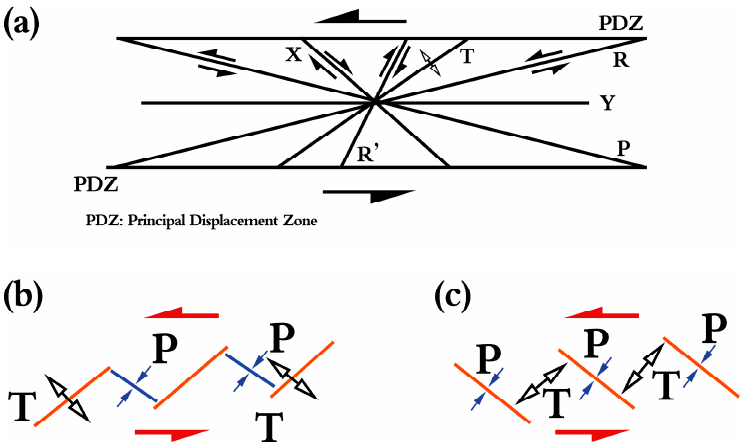
Figure 9. The Riedel shear in strike-slip fault zone. ( a ) An idealized Riedel shear zone is composed of six principal elements, which are X shear and Y shear faults, Riedel (R) and R ′ conjugate shears, T tensional fractures, and P shears, which are all oriented at specific angles with respect to the general trend of the shear zone. ( b ) Mechanism of the right-stepping in strike-slip fault zone. ( c ) Mechanism of the right-stepping in strike-slip fault zone (modified from Li et al. [85]): The blue arrows represent the compressional tectonics, and the white arrows represent the extensional tectonics. The red lines represent the cracks, the bule lines represent squeeze e ff ect on the plane.